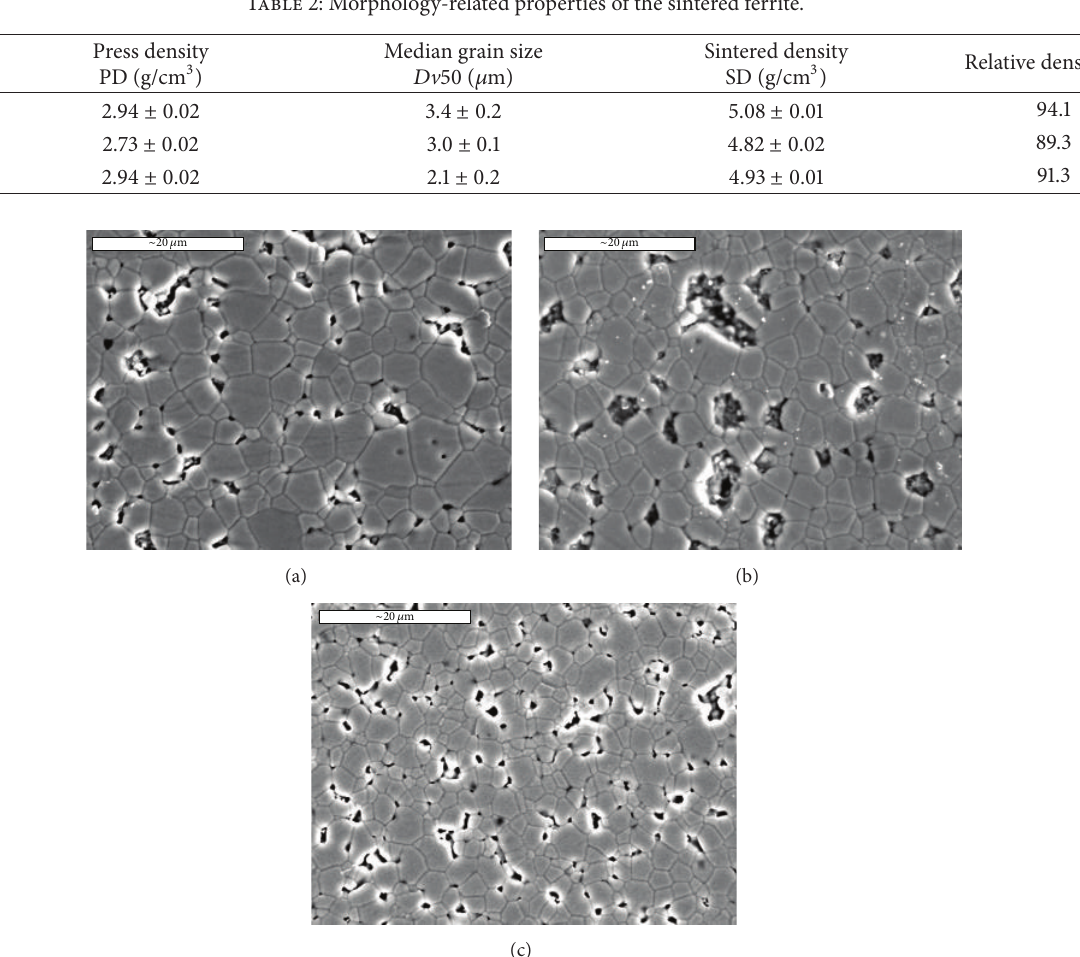
Figure 3: SEM images of the samples (a) S1, (b) S2, and (c) S3. The scale bar length is approximately 20 𝜇 m.